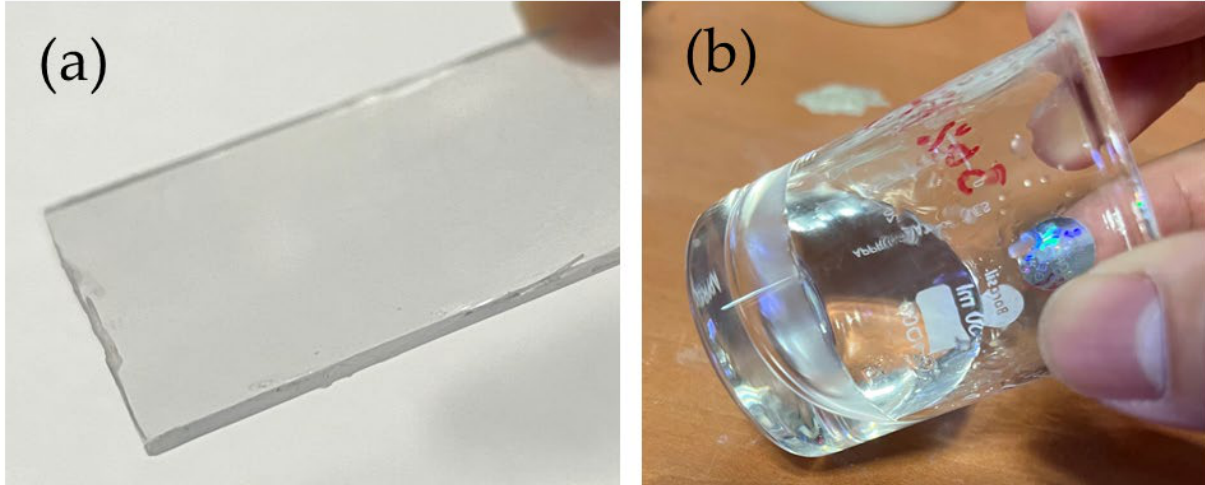
Figure 2. ( a ) Transparent PMMA acrylic sheet and ( b ) PMMA solid electrolyte. Anamika studied solid-state complementary ECD by assembling cathodic WO 3 thin film and anodic NiO thin film on each side of the transparent ITO electrodes with a device structure of ITO/WO 3 /LiClO 4 -PC-PMMA-ACN/NiO/ITO. WO 3 thin film was grown